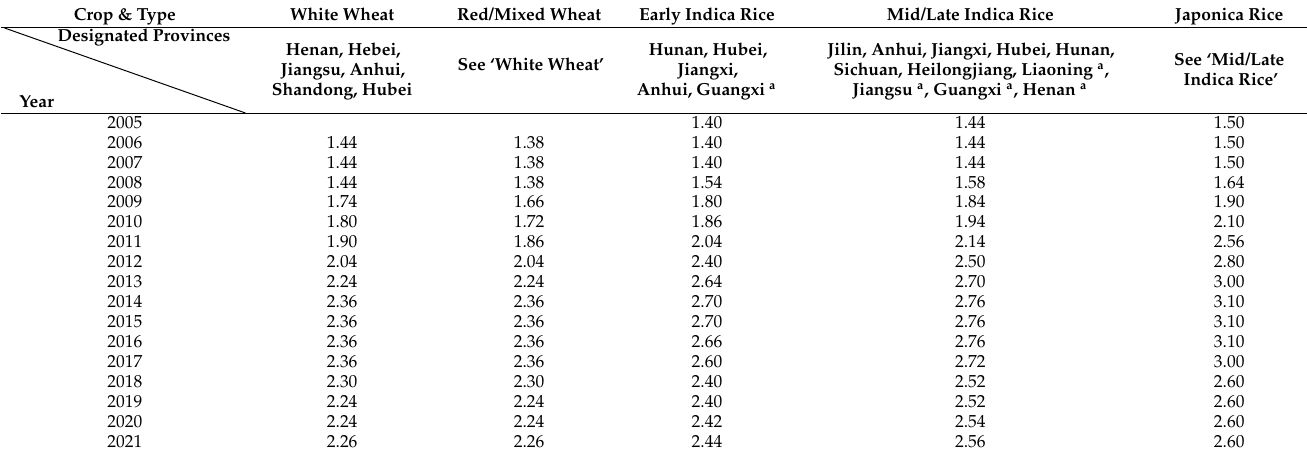
Table 1. Officially applied minimum grain prices (yuan/kg, current-year prices). Crop & Type White